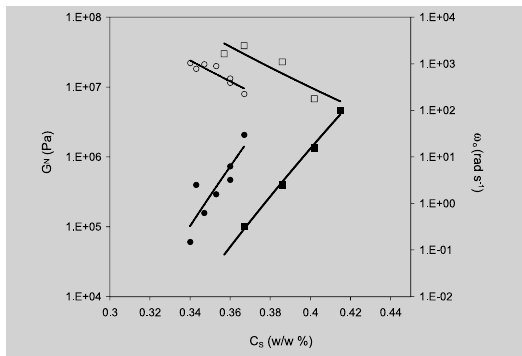
Figure 6 (left): Typical variations of